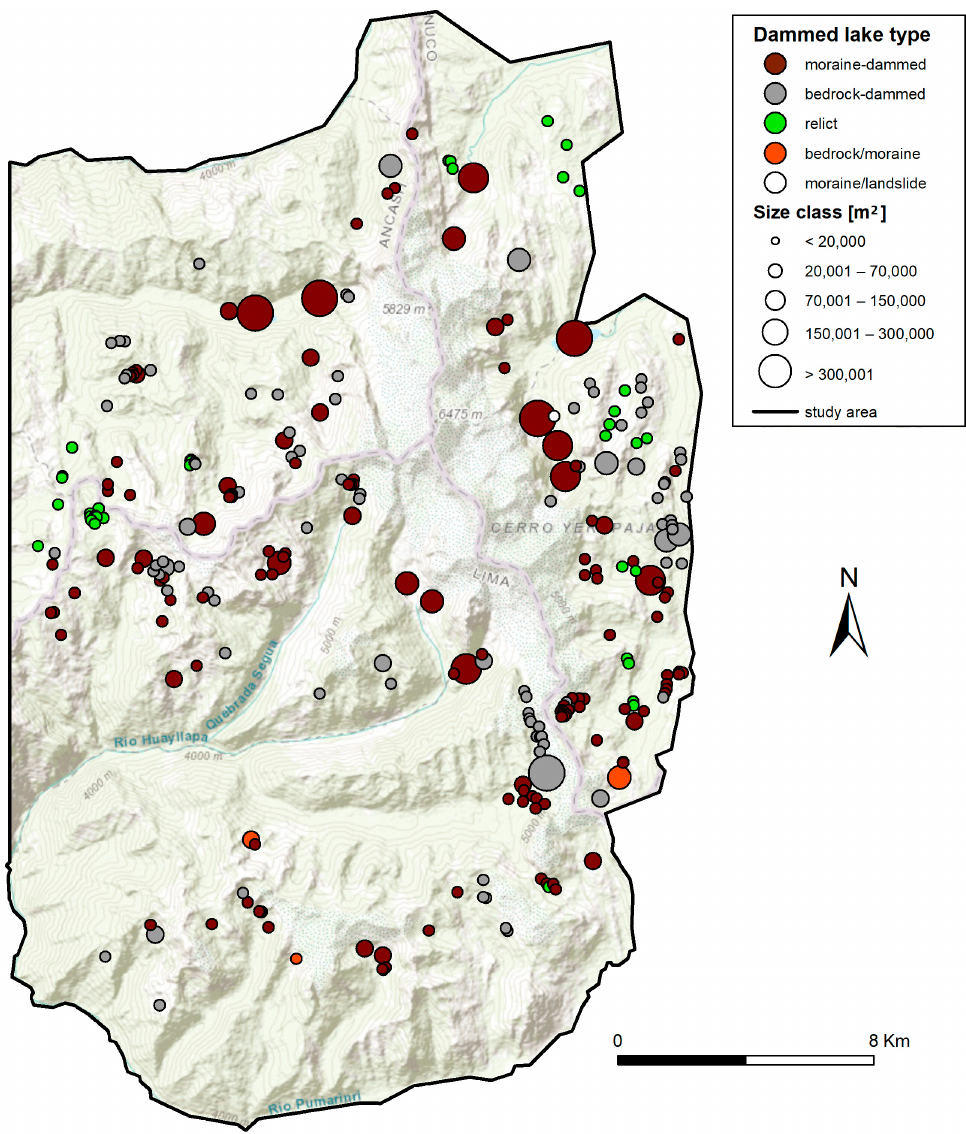
Figure 4. Lake inventory of the Cordillera Huayhuash with lake dam types (see Section 2.1 and Figure 2) and lake sizes. Background map: [40].